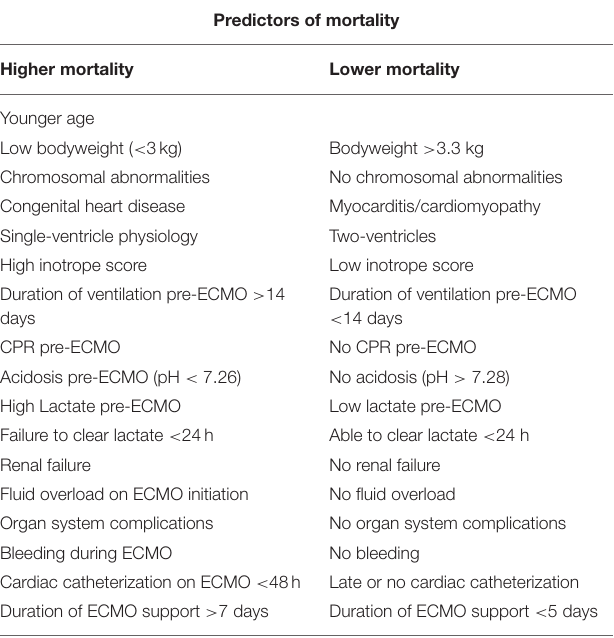
TABLE 7 | Predictors of mortality and survival of neonatal and pediatric cardiac ECMO (7, 8, 23, 31, 39–45). Predictors of